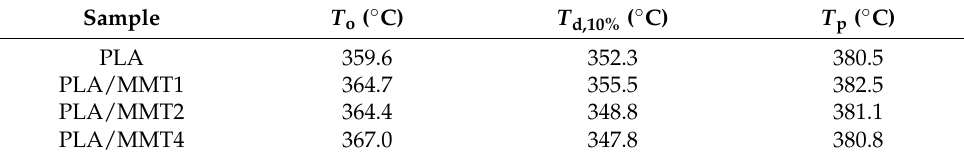
Table 7. Thermal degradation characteristics of PLA neat, PLA, PLA/MMT